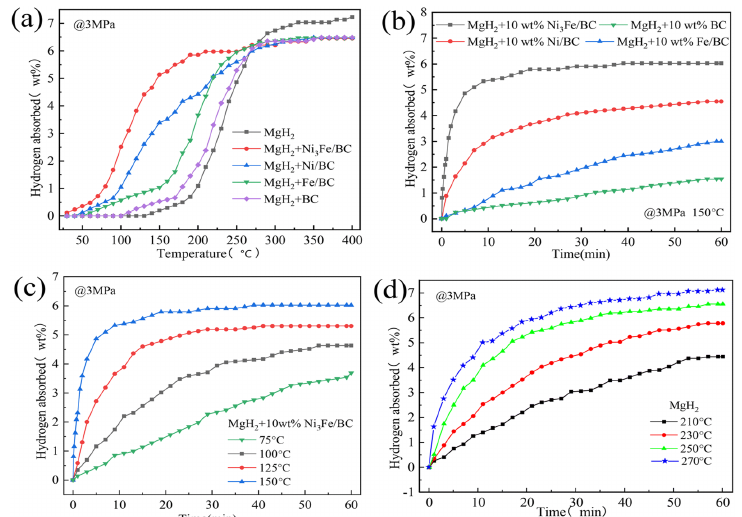
Figure 7. Isothermal hydrogen uptake curves of pure MgH 2 and MgH 2 with 10 wt.% of different catalyst samples ( a ), isothermal hydrogen uptake curves of MgH 2 with 10 wt.% of different catalyst samples under 3 MPa H 2 pressure at 150 °C ( b ), isothermal hydrogen uptake curves of MgH 2 + 10 wt.% Ni 3 Fe/BC composite ( c ) and MgH 2 ( d ) at different temperatures. Copyright 2022, Royal Society of Chemistry. Reproduced with permission from [91].